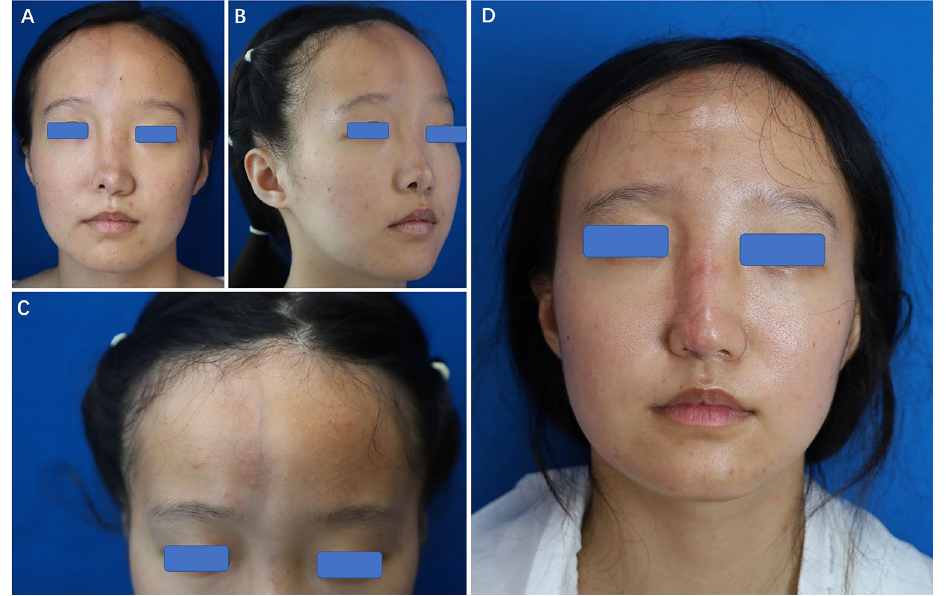
Figure 2. Photos of the patient’s face before and after treatment. ( A – C ) Preoperative photos of patient. ( D ) Photo after two operations—autologous fat transplantation on the atrophic face and local flap